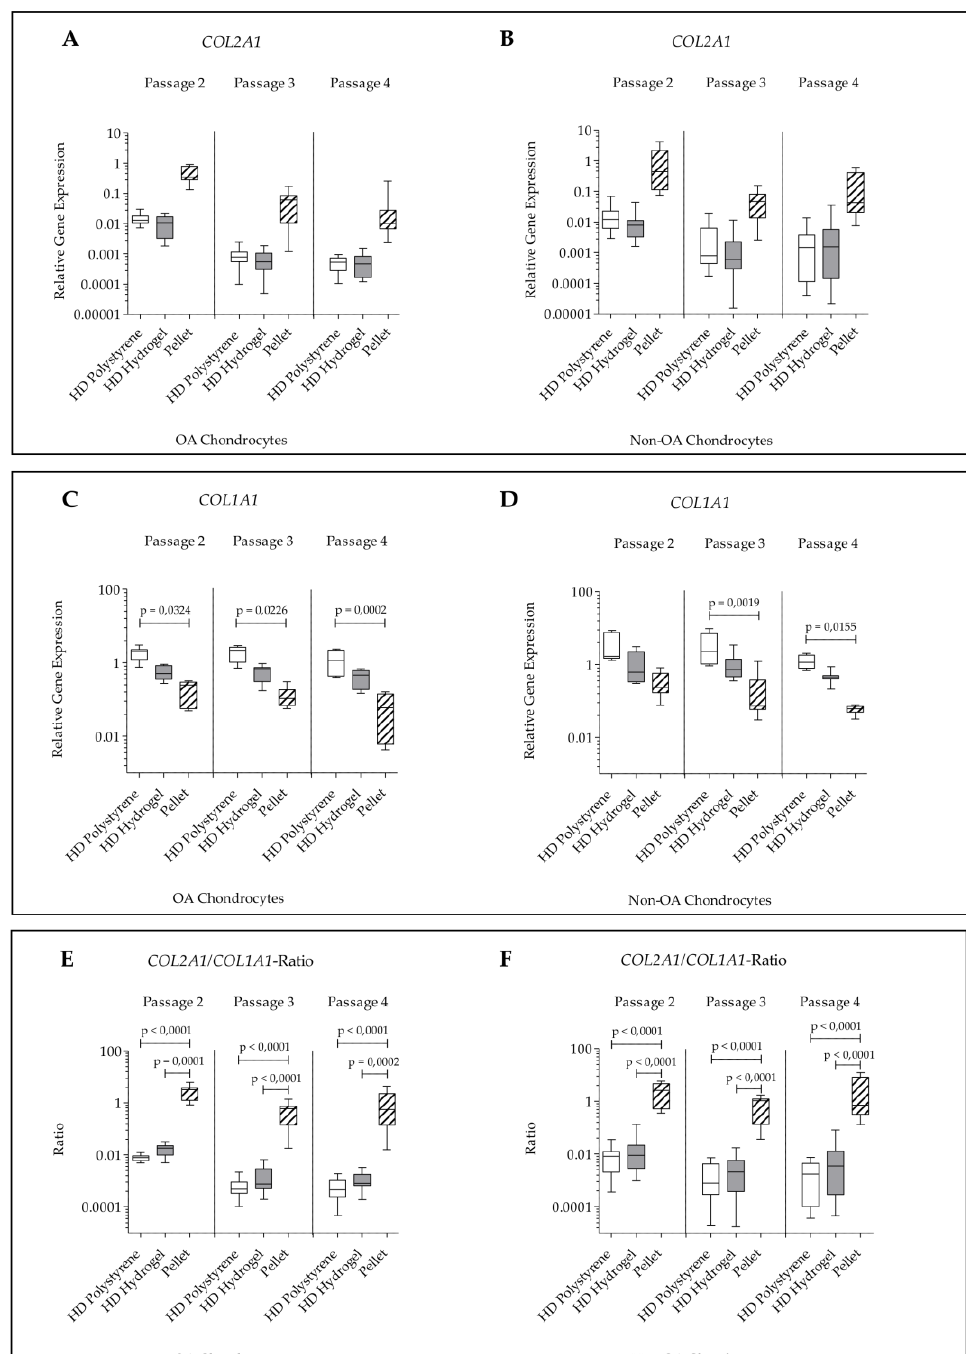
Figure 4. Relative gene expression normalized to GAPDH and day 0 (2 − ∆∆ C t ) of human articular chondrocytes after 7 days of culture in passage 2, 3, and 4 on hydrogel, on polystyrene or in pellet culture. ( A ) COL2A1 expression in OA chondrocytes; ( B ) COL2A1 expression in non-OA chondrocytes; ( C ) COL1A1 expression in OA chondrocytes; ( D ) COL1A1 expression in non-OA chondrocytes; ( E ) COL2A1 / COL1A1 -ratio in OA chondrocytes; ( F ) COL2A1 / COL1A1 -ratio in non-OA chondrocytes.